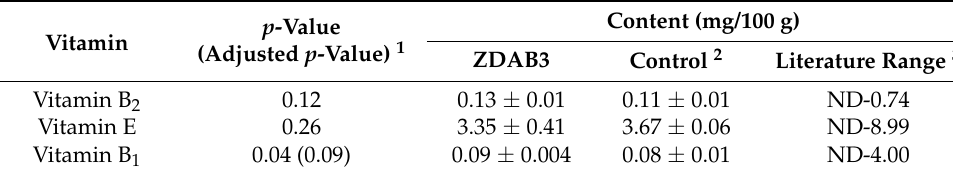
Table 6. Vitamin values in maize